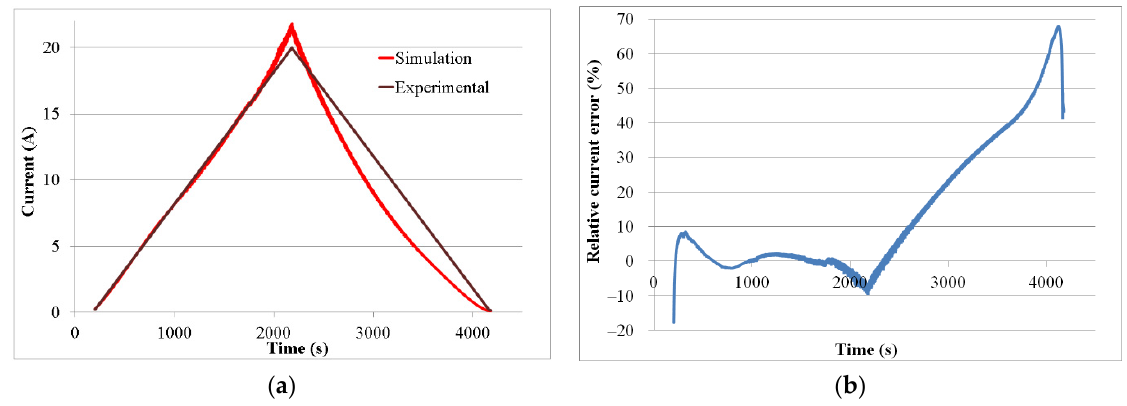
Figure 7. ( a ) Simulation and experimental curves of current. ( b ) Relative error of simulated current.